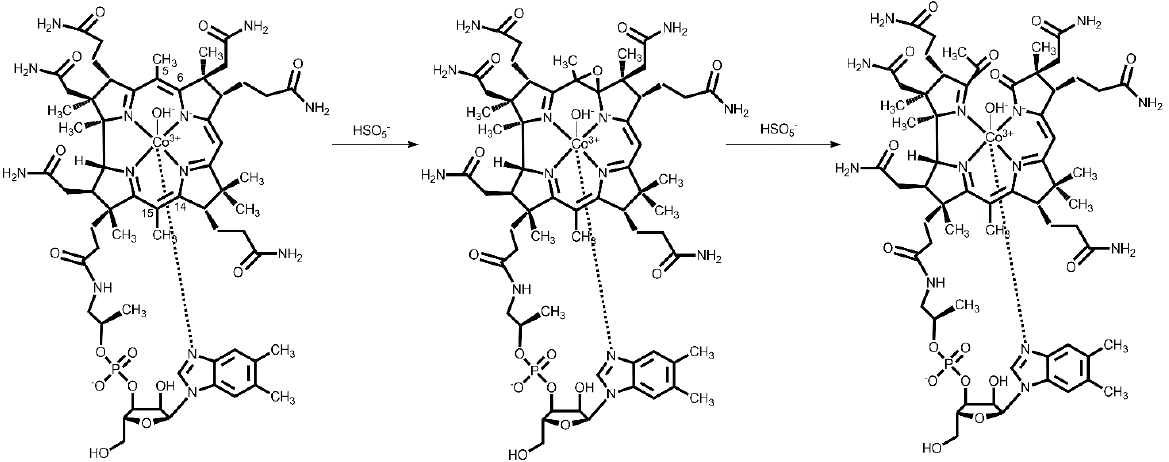
Figure 4. ( A ) UV-vis spectra of H 2 OCbl (5.0 · 10 − 5 M; spectrum 1) and the products generated by the reaction between H 2 OCbl and the two-fold excess of HSO 5 − (spectrum 2), recorded at pH 7.4, 25.0 ◦ C. ( B ) Time-course curves of the Orange II (5.8 · 10 − 5 M) destruction in the mixtures of HSO 5 − (5.0 · 10 − 4 M) with H 2 OCbl (1.0 · 10 − 6 M; curve 1) and the products generated by the reaction between H 2 OCbl and the two-fold excess of HSO 5 − (ca. 1.0 · 10 − 6 M; curve 2) at pH 7.4, 25.0 ◦ C.